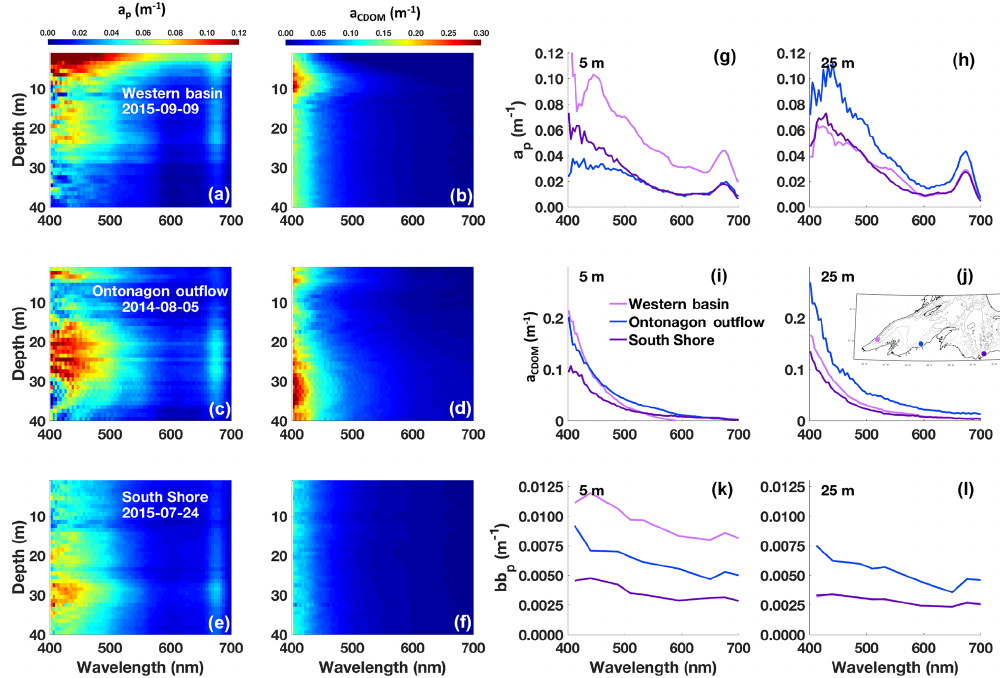
Figure 7. In situ IOP for select stations throughout Lake Superior in the summer of 2014 and 2015 (see inset map in j ). Profiles of a p ( λ ) (a, c, e) and a CDOM ( λ ) (b, d, f) for the western basin (a, b) , Ontonagon River outflow (c, d) , and South Shore (e, f) . Note the different color scales for the a p ( λ ) and a CDOM ( λ ) profiles. Examples of individual spectra at 5 and 25m are shown in (g) – (j) along with in situ particulate backscattering (k, l) . Data are binned to